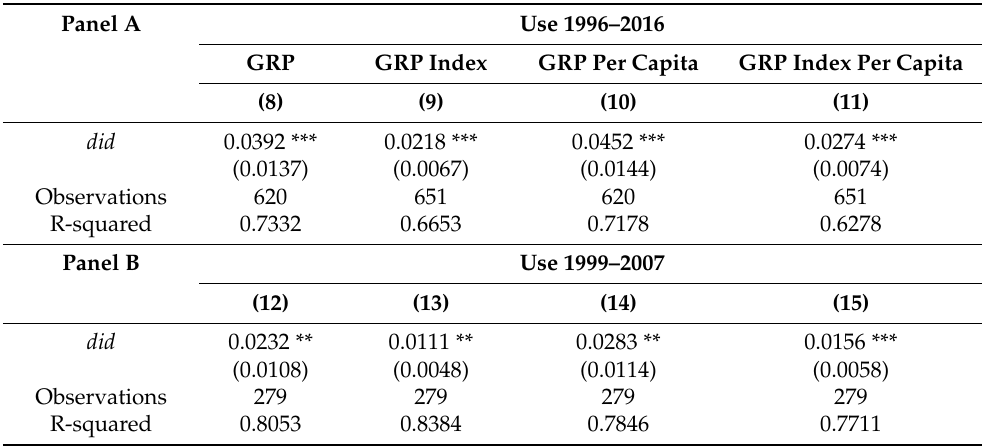
Table 2. Robustness